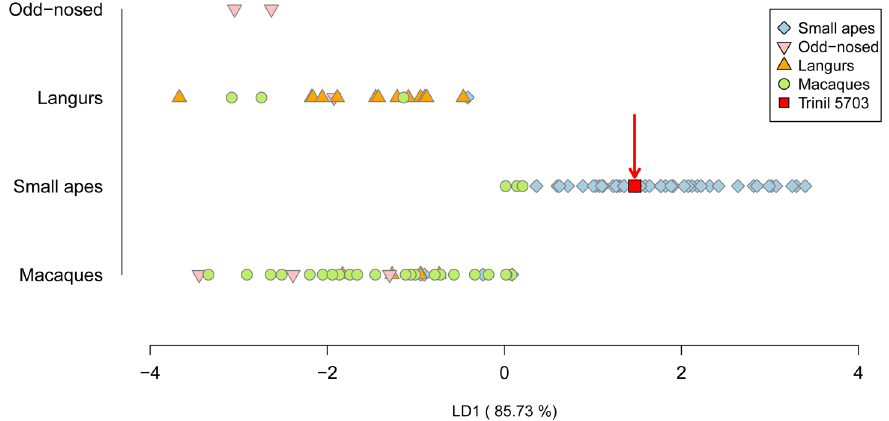
Figure 10. Linear discriminant analysis on log-shape ratios.